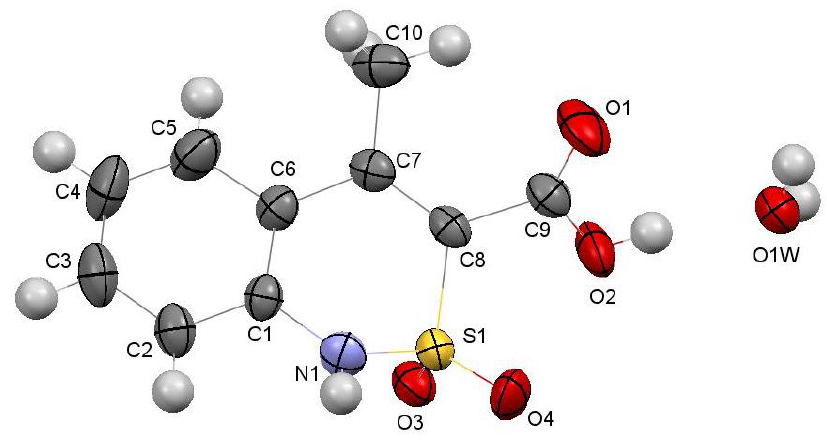
Figure 5. The molecular structure of acid monohydrate 4 with atoms represented by thermal vibration ellipsoids of 50% probability.